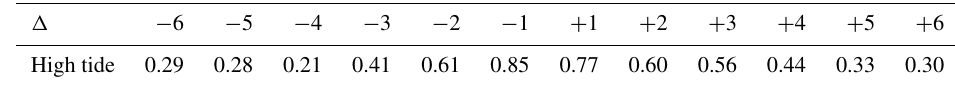
Table 5. Spearman’s ρ calculated between high tide and all the instantaneous surges in the tidal cycle. (cid:49) − 6 − 5 − 4 − 3 − 2 − 1 + 1 + 2 + 3 + 4 + 5 + 6 High tide 0.29 0.28 0.21 0.41 0.61 0.85 0.77 0.60 0.56 0.44 0.33